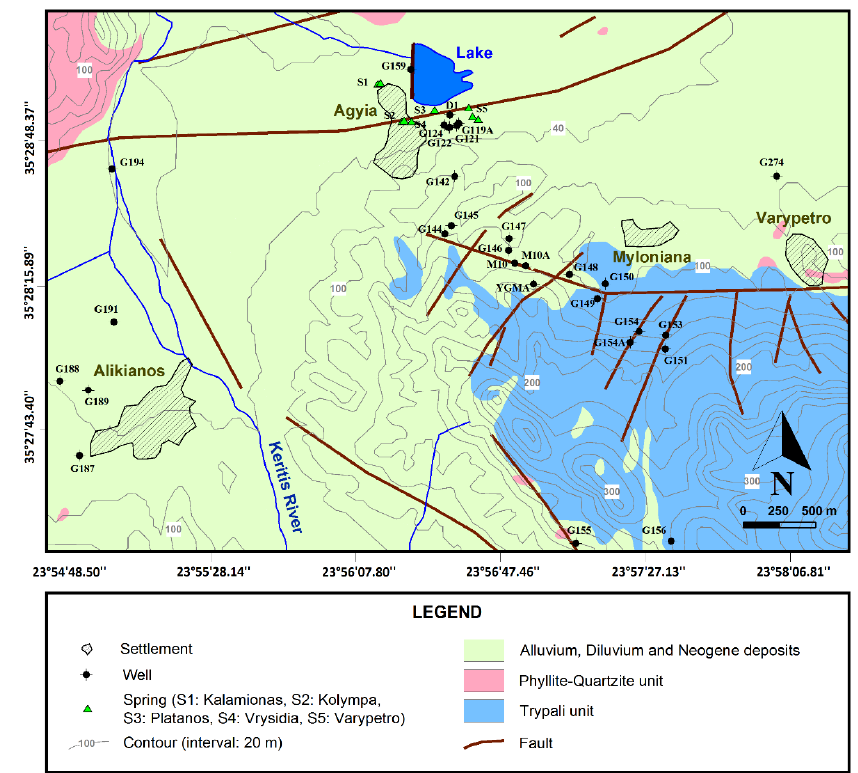
Figure 5. Geological map of the aquifer discharge zone (fine scale modeling area).